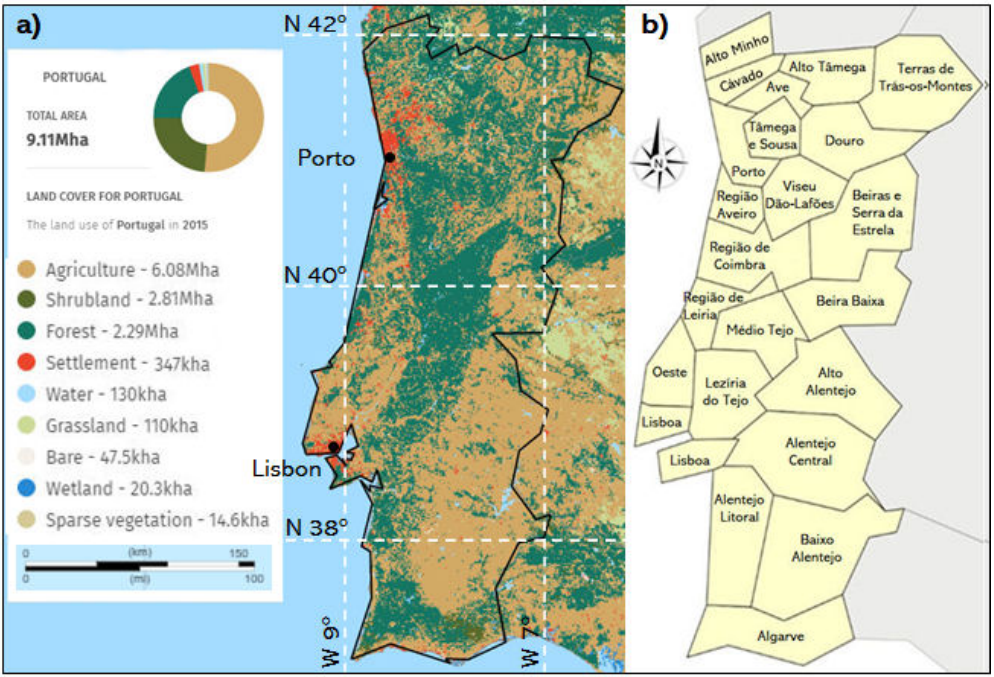
Figure 1. (a) Land cover in mainland Portugal in 2015 (Global Forest Watch, https://www.globalforestwatch.org, last access: 10 Octo- ber 2020; (b) mainland Portugal NUTS III